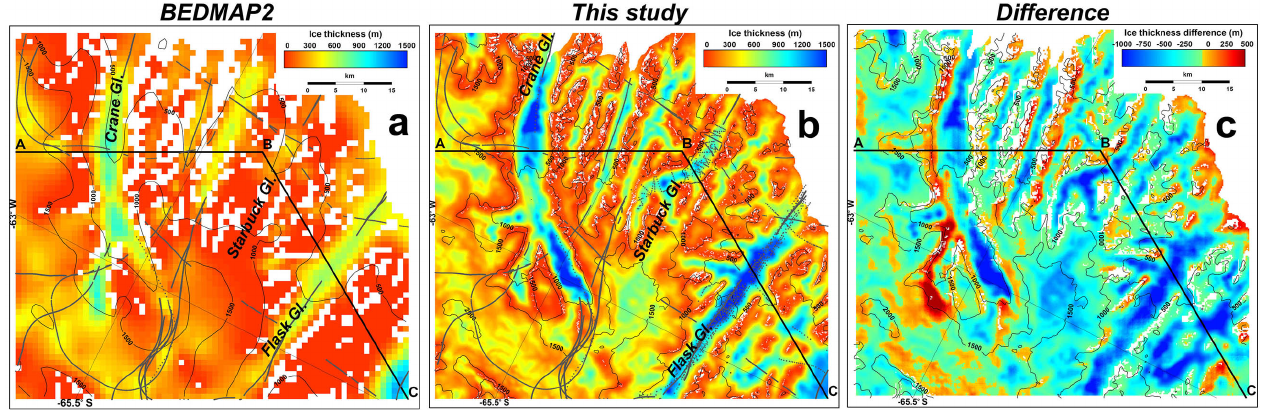
Figure 9. Comparison of Bedmap2 (Fretwell et al., 2013) to the new bedrock data set around Crane/Starbuck/Flask Glacier (Fig. 1). Ice thickness according to (a) Bedmap2, (b) this study, and (c) the difference (a − b) . A profile along A–B–C is shown in Fig. 10.